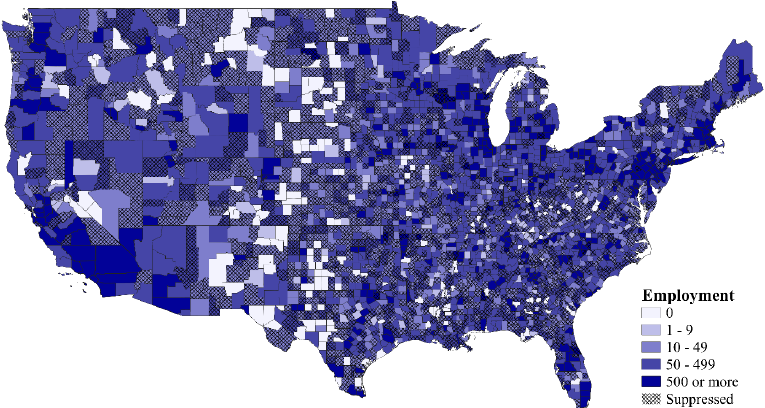
Figure A.2: Employment Distribution of General Freight Trucking (NAICS 4841)